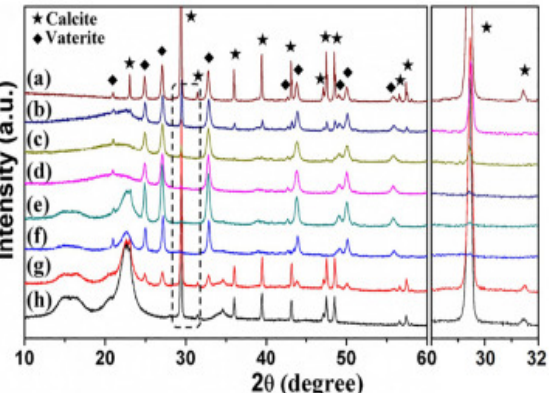
Figure 5. XRD patterns of the products prepared with different cellulose concentrations: ( a ) the control sample obtained without cellulose; ( b ) 0.51 mg mL −1 ; ( c ) 1.01 mg mL −1 ; ( d ) 2.03 mg mL −1 ; ( e ) 4.05 mg mL −1 ; ( f ) 8.10 mg mL −1 ; ( g ) 16.20 mg mL −1 ; ( h ) 32.40 mg mL −1 . Taken with permission from [17].